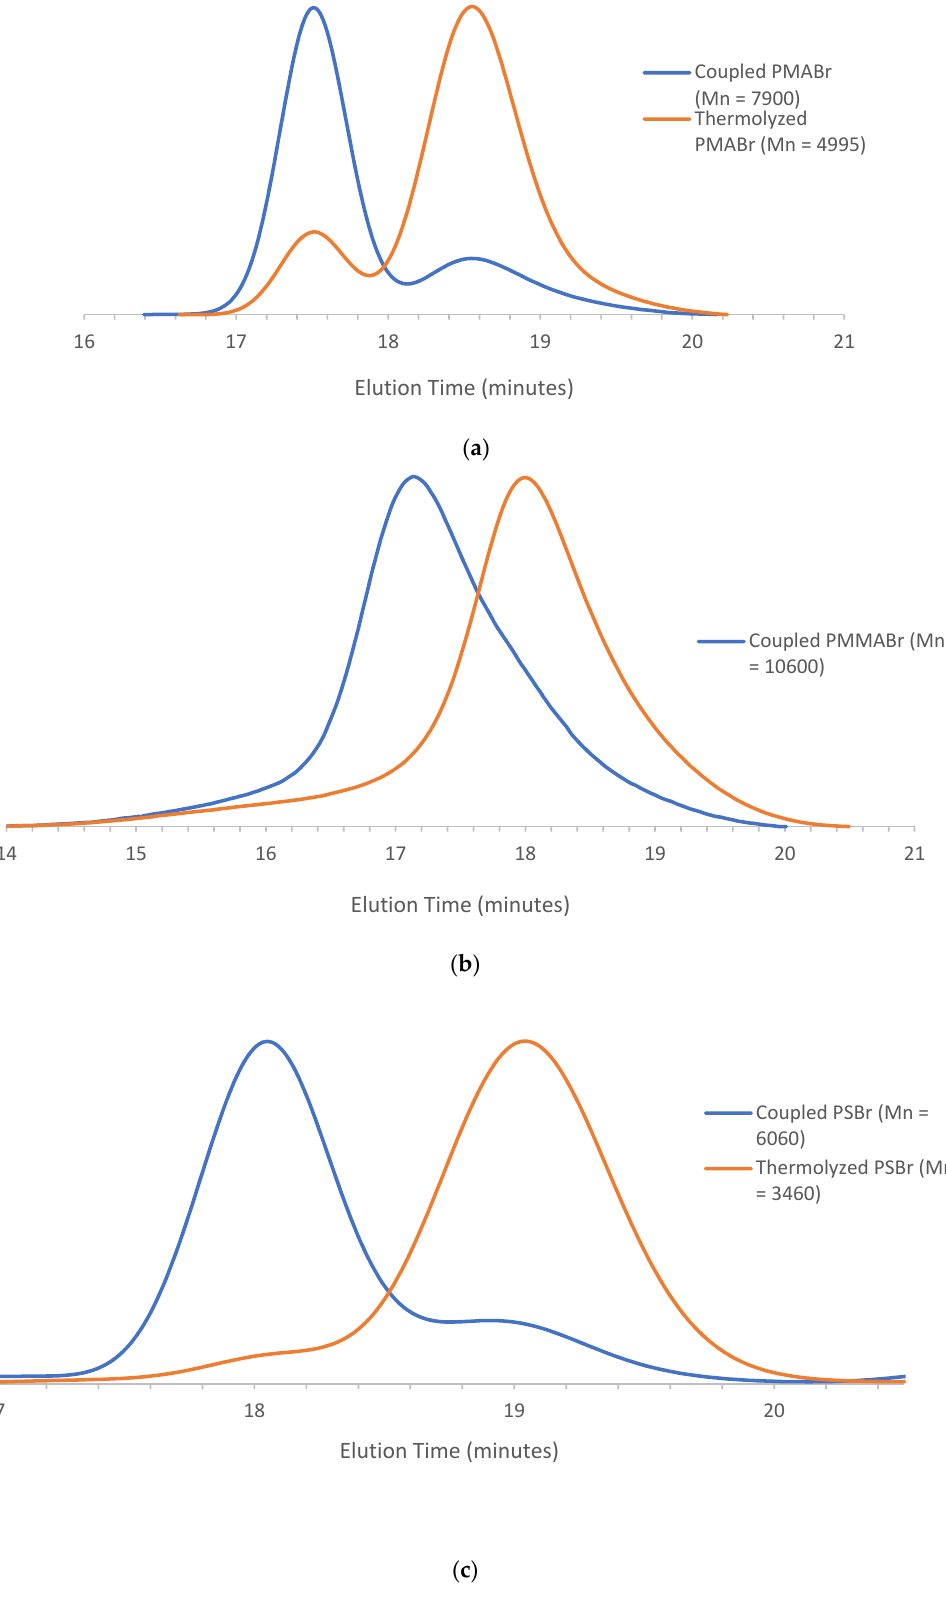
Figure 5. GPC traces of RTA-ATRC product pre- (blue) and post- (orange) thermolysis for ( a ) PMABr; ( b ) PMMABr and ( c ) PSBr. Note that the Mn values of the brominated precursor and thermolyzed product are given on each figure.